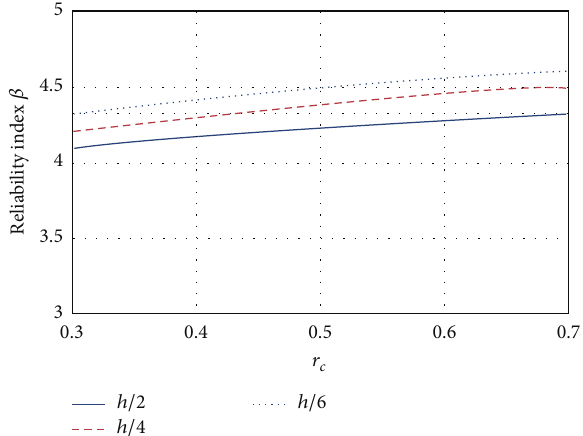
Figure 8: Influence on the structural reliability of the transversal